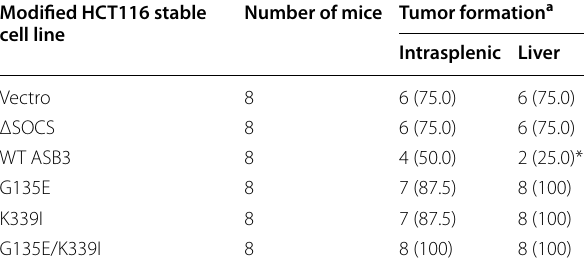
* P < 0.05 compared with other groups (Students’ t test) a The data are presented as the number of mice with tumors followed by percentage in parentheses